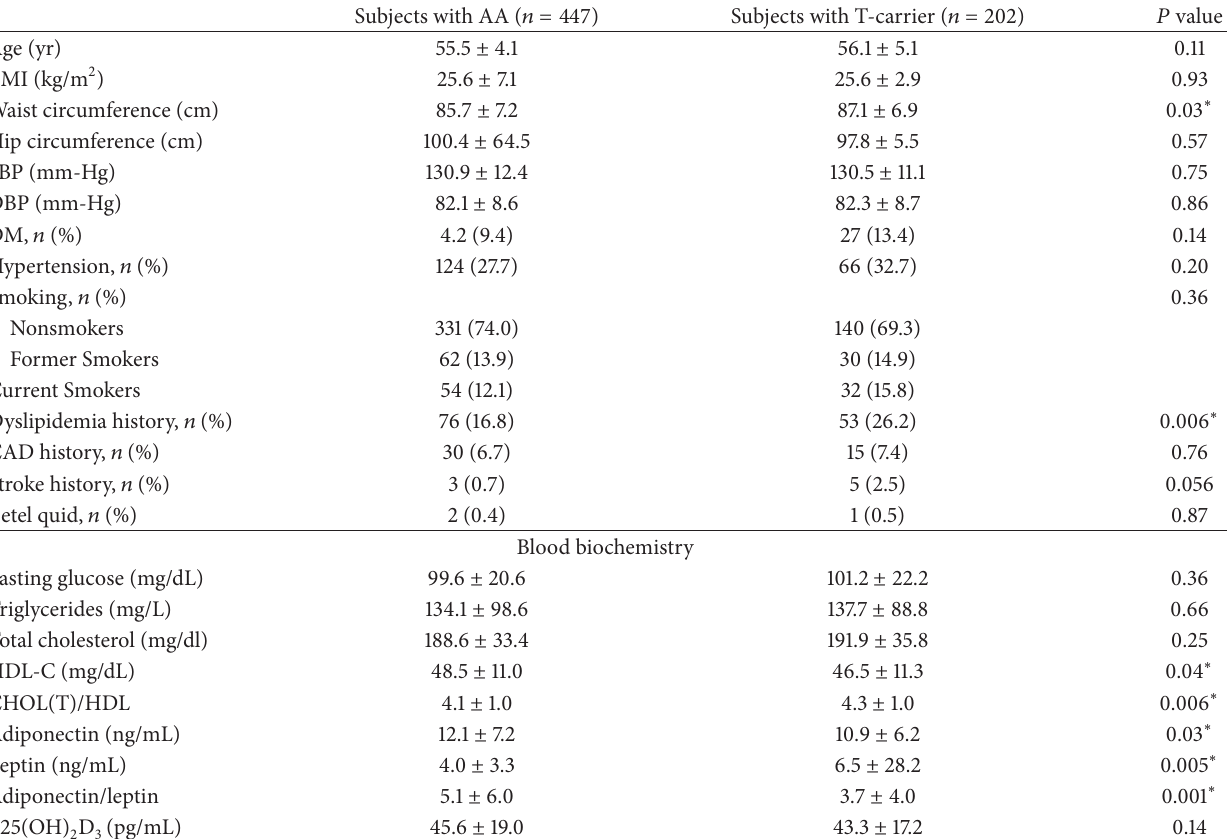
Table 1: Means ± standard deviations or numbers (%) of the baseline characteristics and biochemical variables in the patients with the CYP27A1 rs4674344